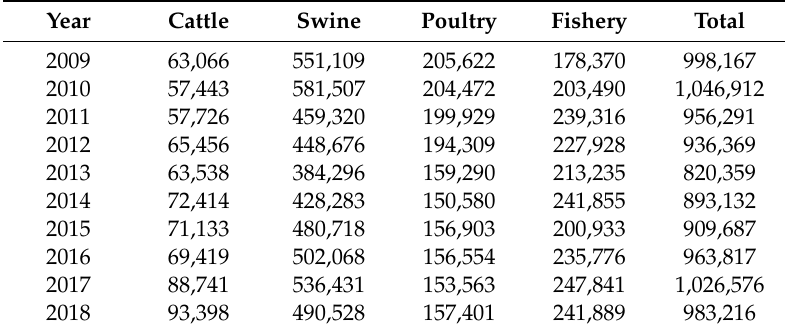
Table 1. Sales performance of antibiotics for di ff erent livestock species (Unit: kg) [6]. Year Cattle Swine Poultry